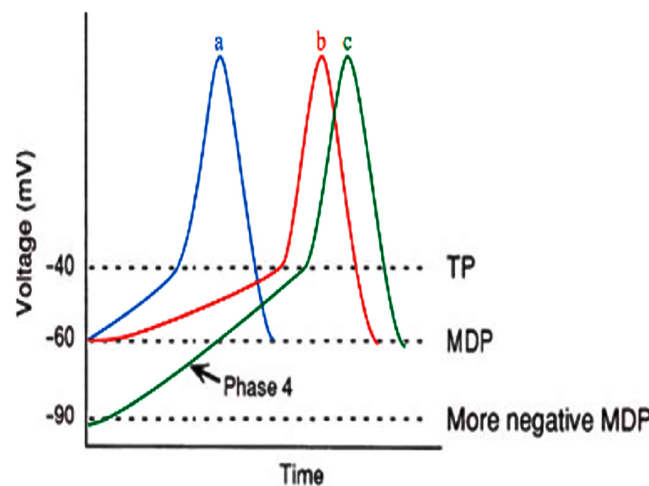
Figure 1. Phase 4 depolarization in a pacemaker cell [45]. MDP, maximum diastolic potential; TP, threshold potential. Blue (a) curve is normal action potential; red (b) curve is reducing I f , which renders the slope of phase 4 less steep, therefore, the time required to reach threshold TP is elevated; green (c) curve means the MDP is more negative, thus the time required to reach TP is augmented. Sci. Pharm. 2020 , 88 , x FOR PEER REVIEW